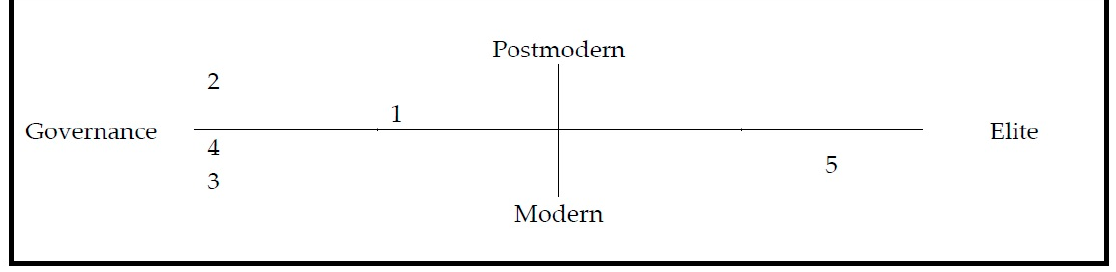
Figure 2. Core Values.